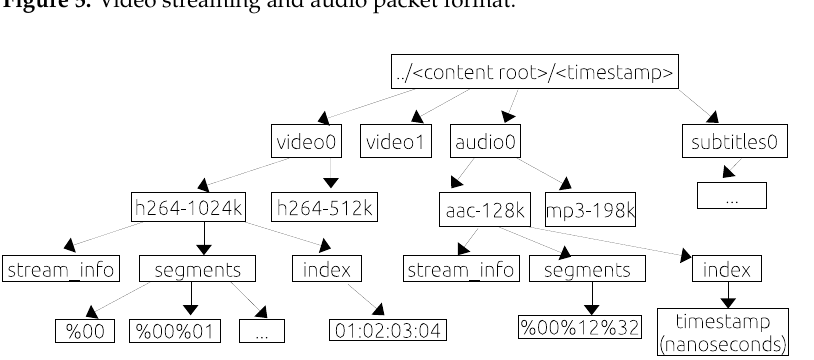
Figure 5. Video streaming and audio packet format.